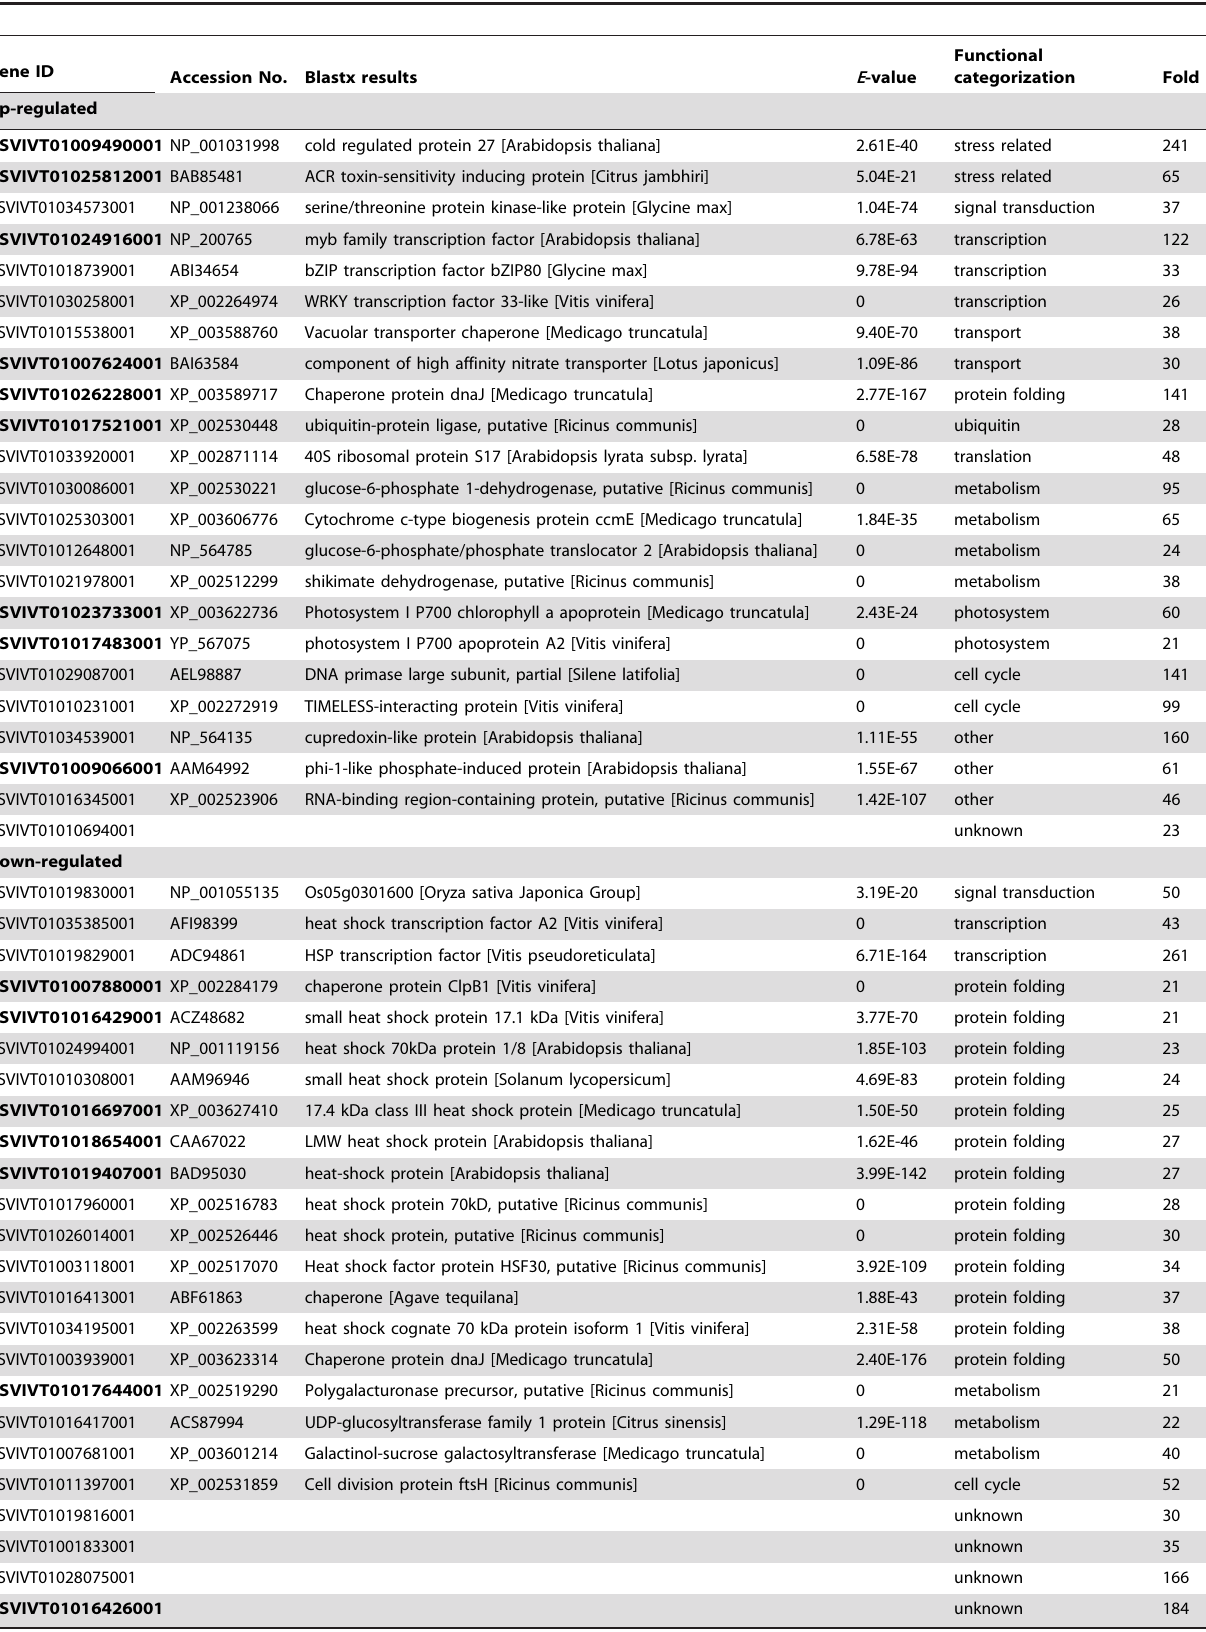
Table 5. List of DEGs changed for 20 fold and more in Vitis vinifera cv. Muscat of Hamburg.